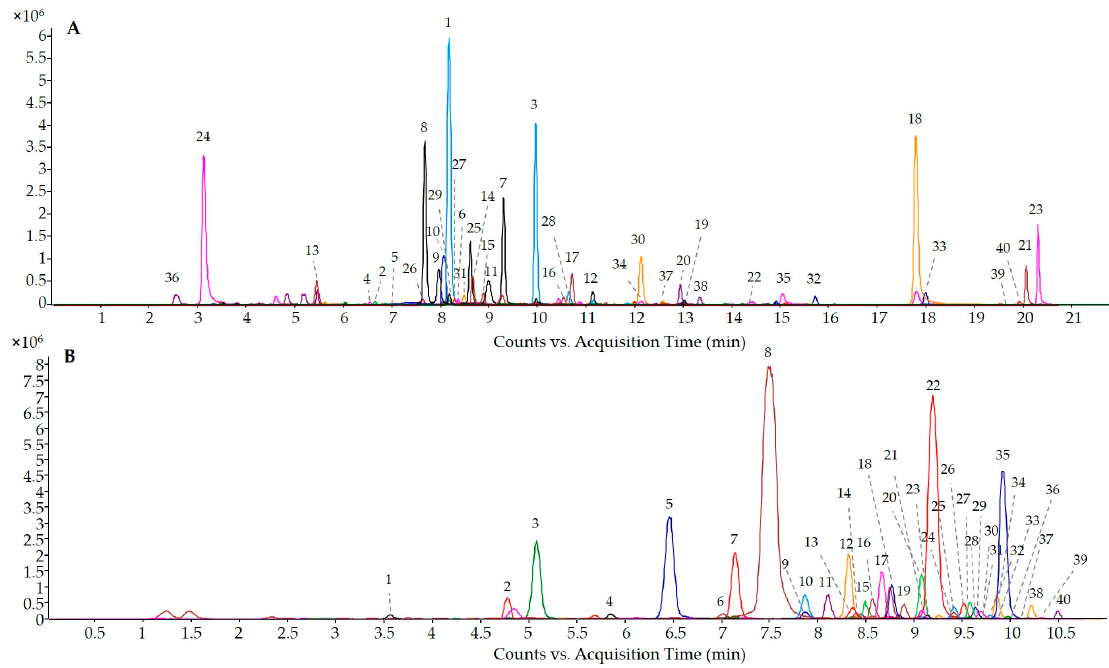
Figure 3. Overlapped extract ion chromatograms (EIC) of ( A ) non-anthocyanin wine lees (WL)-phenolic compounds analyzed by UHPLC-(ESI-)-Q-TOF-MS and ( B ) anthocyanin WL-phenolic compounds analyzed by UHPLC-(ESI + )-Q-TOF-MS. Chromatographic peaks are numbered according to Tables 3 and 4 . Table 2. Total composition of flavanols, flavonols, phenolic acids, stilbenes, and anthocyanins in studied wine lees (WL).